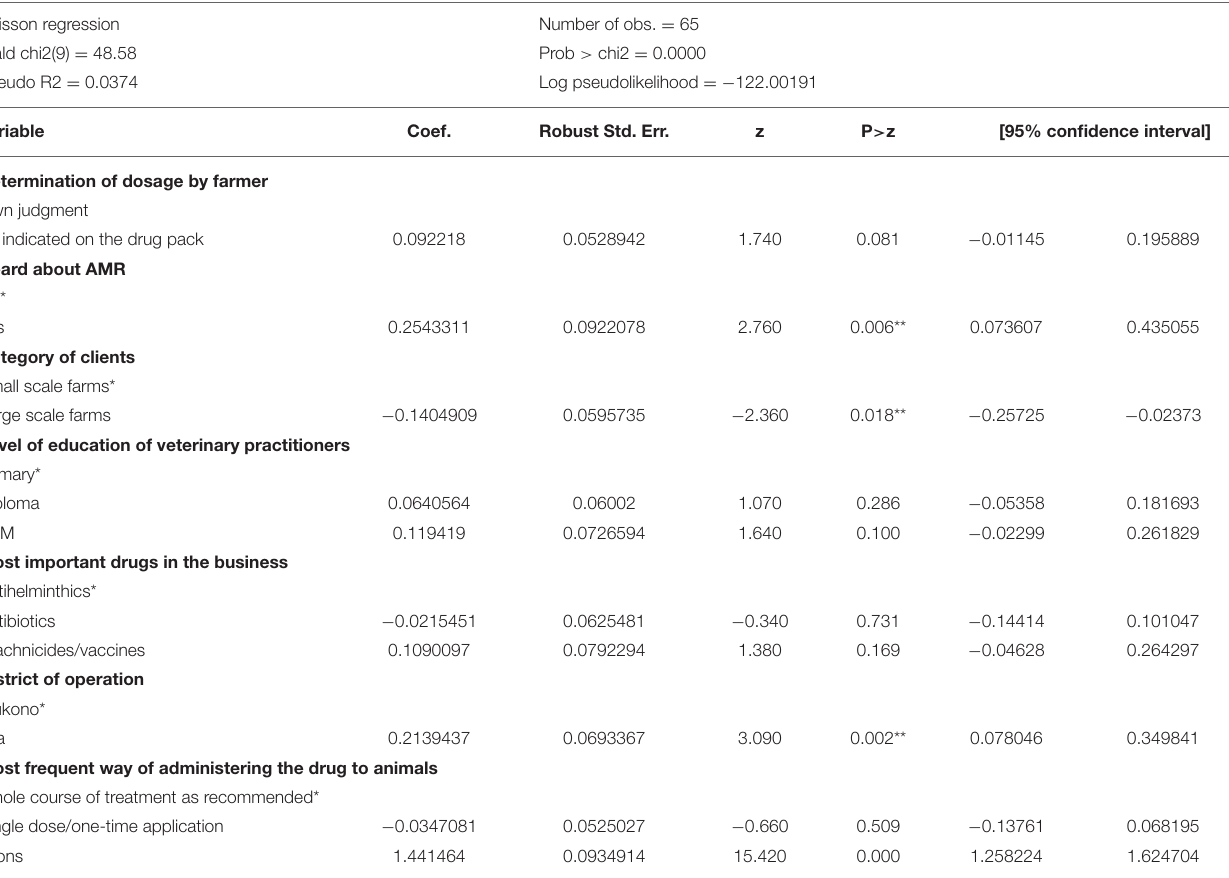
TABLE 8 | Factors associated with knowledge of veterinary practitioner about antibiotics and AMR. Poisson regression